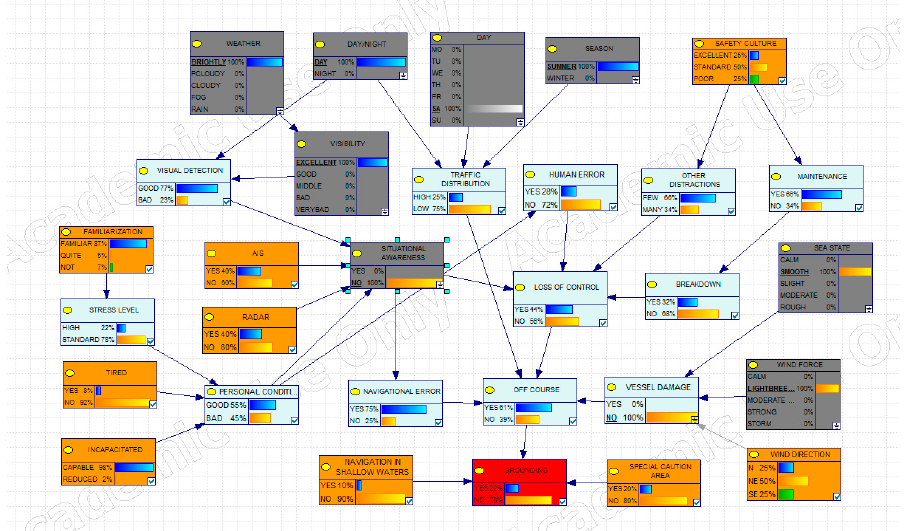
Figure 9. Model of the grounding of a small passenger ship “Zlatni Zal” according to the report on the maritime accident.